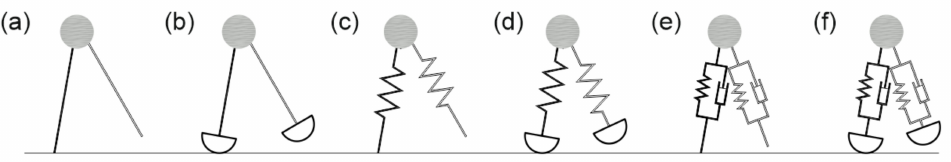
Figure 5. Bipedal walking locomotion models: ( a ) inverted pendulum [31], ( b ) inverted pendulum with rocker foot [30], ( c ) spring-loaded inverted pendulum, SLIP [48], ( d ) SLIP with rocker foot [49], ( e ) spring mass with damper [22], and ( f ) spring mass with rocker foot and damper